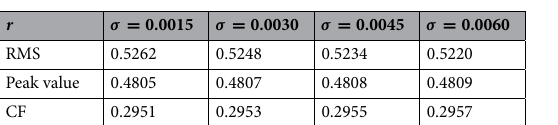
Figure 30. The characteristic indicators of XJTU-SY bearing under different perturbation intensities.